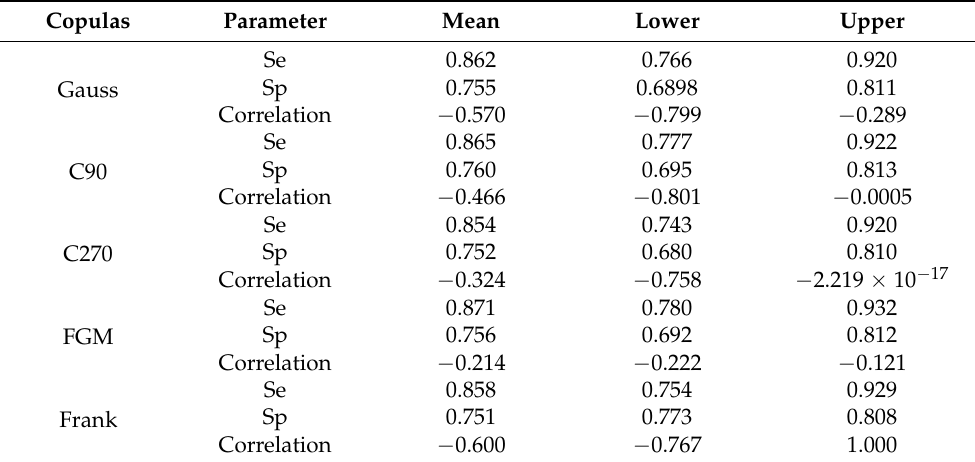
Table 2. Posteriori means, 95% confidence intervals, and estimated sensitivity, specificity, and corre- lation parameters for different copulas for AuditC data.